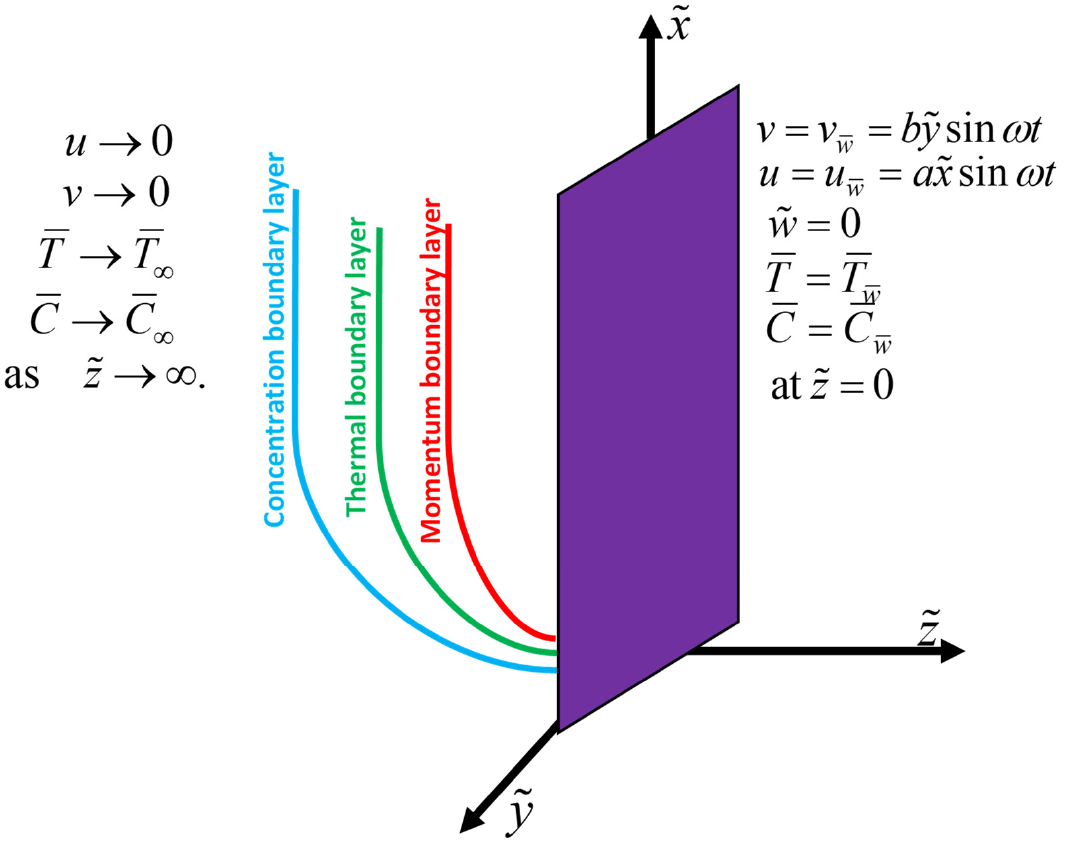
Figure 1. Flow geometry of the problem .